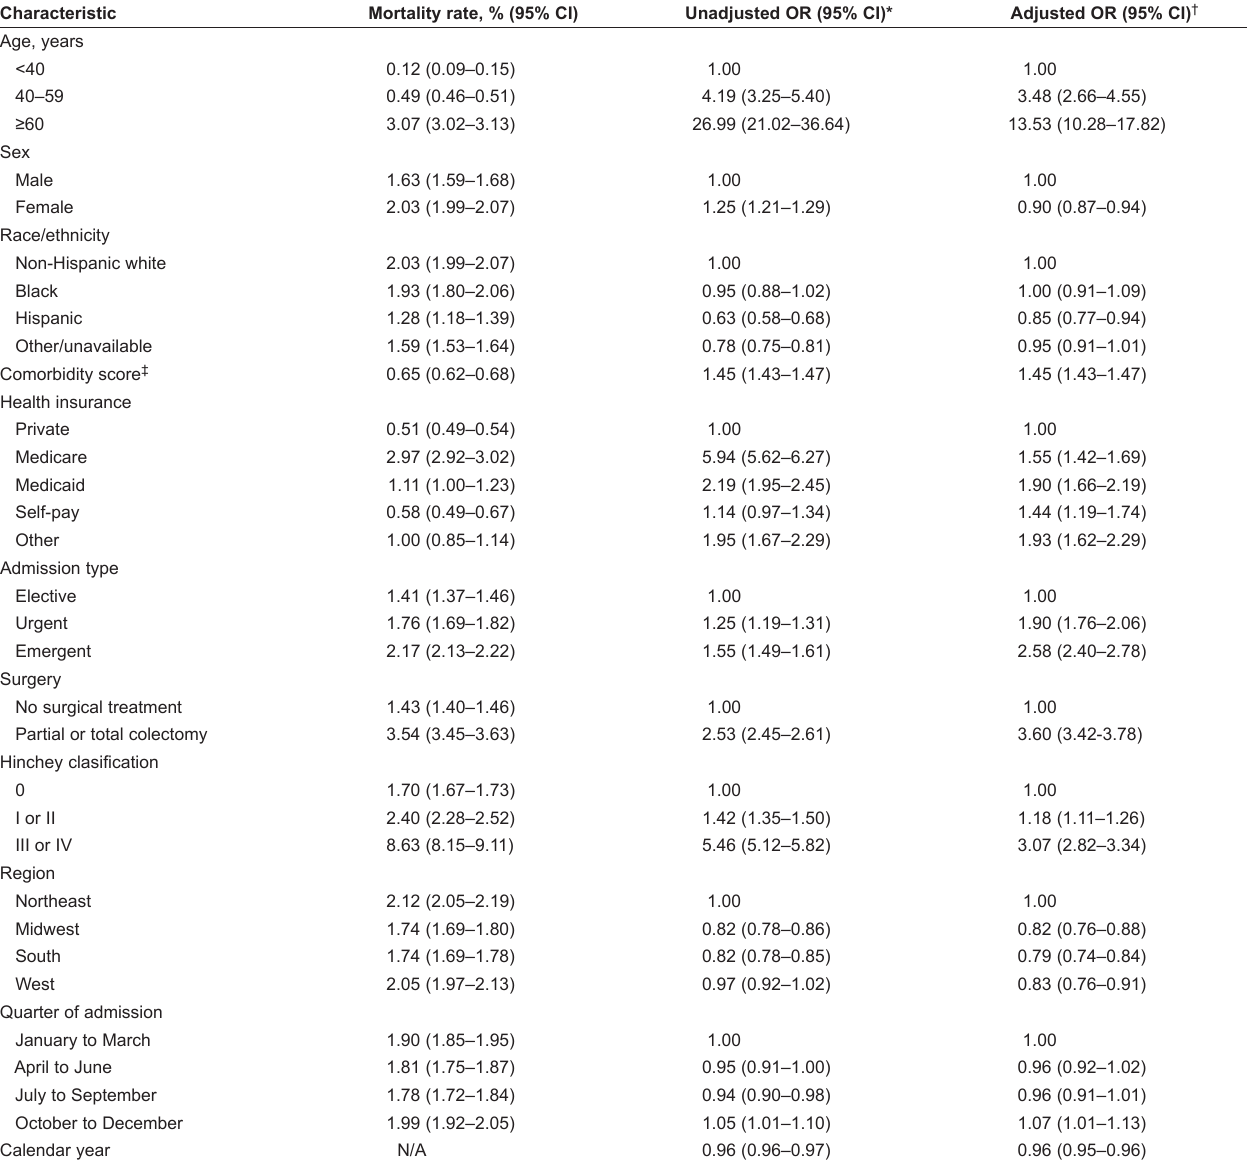
TABLE 3 Demographic and hospital-level predictors of in-hospital mortality in patients hospitalized for diverticulitis